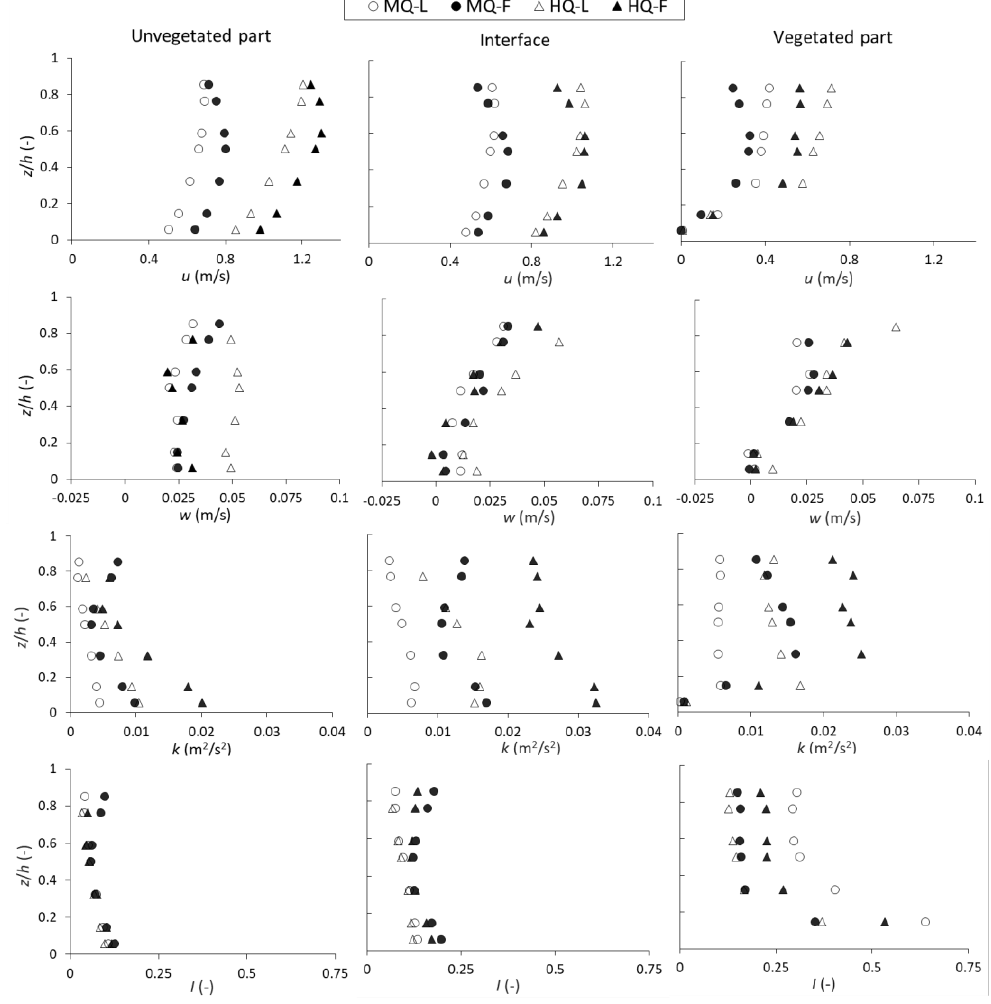
Figure 9. Vertical profiles of the time-averaged streamwise flow velocity u , vertical flow velocity w , turbulent kinetic energy k , and turbulence intensity I for the unvegetated part (at y = −150 mm), the interface ( y = 0 mm), and the vegetated part ( y = 130 mm) of the channel in the fully developed region of the flow at x / h = 68. The bottom grasses extended from z / h = 0 to z / h = 0.15 in the vegetated part of the channel. MQ = medium flow rate (50 L / s); HQ = high flow rate (83 L / s); L = leafless; F =